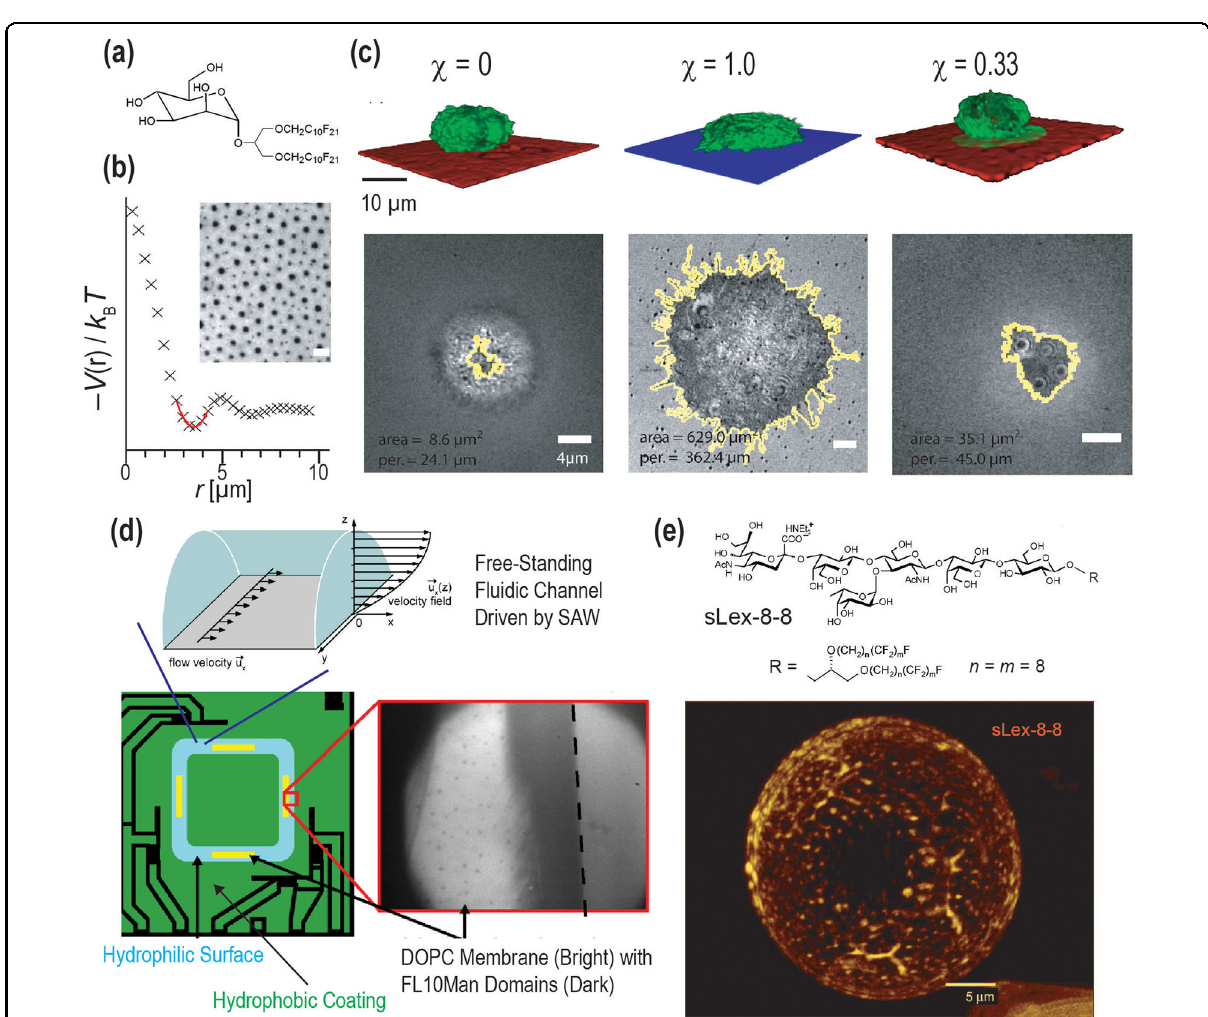
Fig. 5 Highly ordered biofunctional domains used as biomimetic coating materials. a Chemical structure of FL10 coupled to mannose (FL10Man). b Normalized potential of mean force and fl uorescence image of FL10Man indicating the dominant role of dipole repulsion in the formation of highly ordered domains. c Membrane with FL10Man domains used as a biomimetic coating material for cells. Adhesion of a macrophage cell on a pure phospholipid membrane (left), pure FL10Man membrane (middle), and membrane incorporating FL10Man at χ = 0.33 (right). The cells form discrete contact points on the FL10Man domains. d Integration of FL10Man-incorporating membranes into coverless micro fl uidics driven by a surface acoustic wave (SAW) to investigate cell adhesion under high shear stress. e Cell-sized leukocyte model coated with sialyl-LewisX antigen microdomains. Adapted from refs. 29,70,78